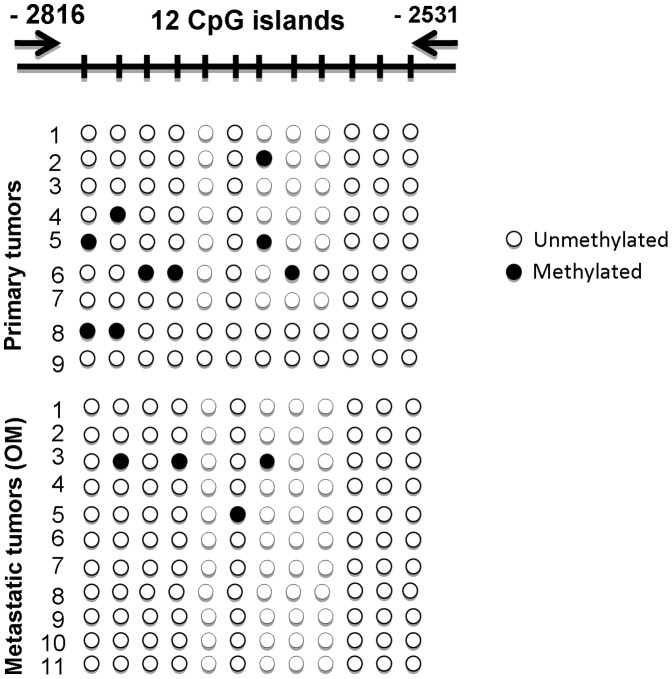
BSP analysis of the methylation status of RUNX2 in grade 3 primary serous EOC tumors compared to omental metastases.Filled circles represent methylated CpGs and open circles represent unmethylated CpGs. CpG plot of the analyzed region is also presented (CpGs are displayed with vertical marks). The indicated positions on the CpG plot represent the number of nucleotides stretching upstream of the first exon of the RUNX2 gene.